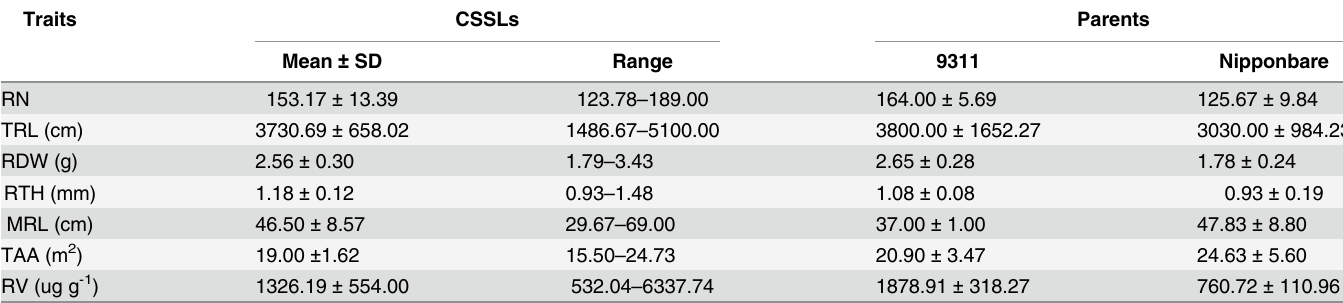
Table 1. Mean values and ranges of the seven root traits in the parents and CSSLs. Traits